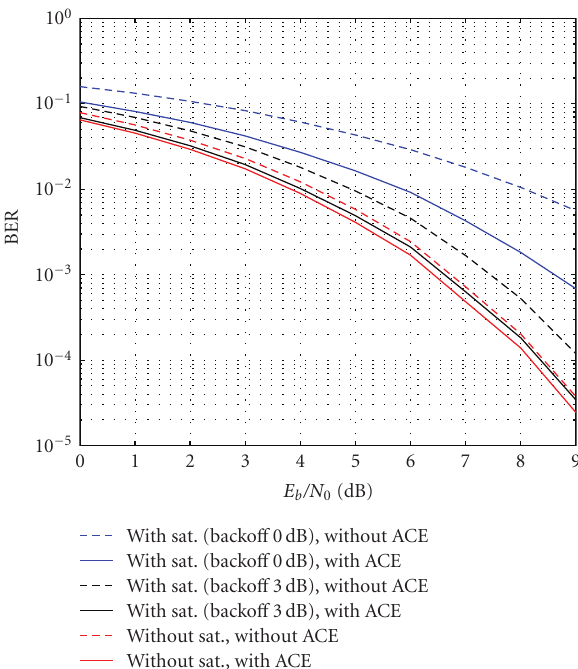
Figure 2: BER Performance Results with 2-Tx antenna STBC using 256 subcarriers employing QPSK under AWGN